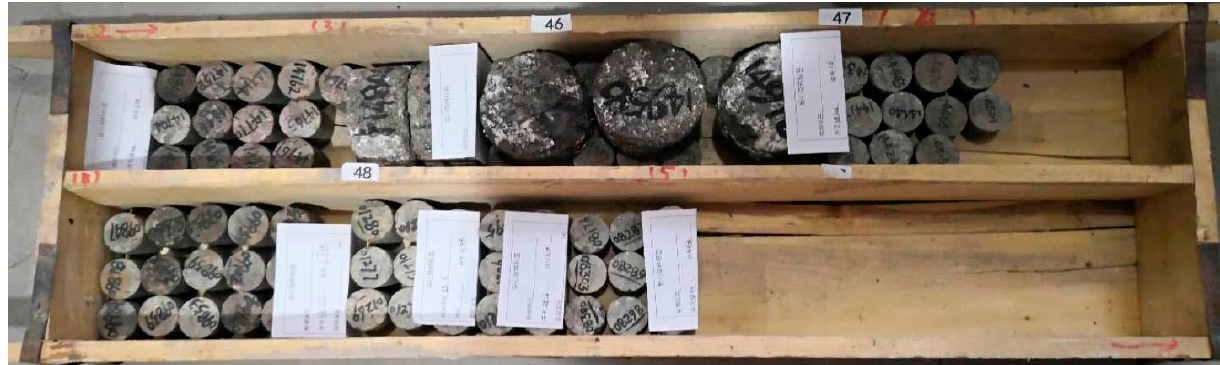
Figure 4. Core data of Baikouquan Formation in Ma18 Well Block and Ma131 Well Block. Table 2. Information on the experimental samples.